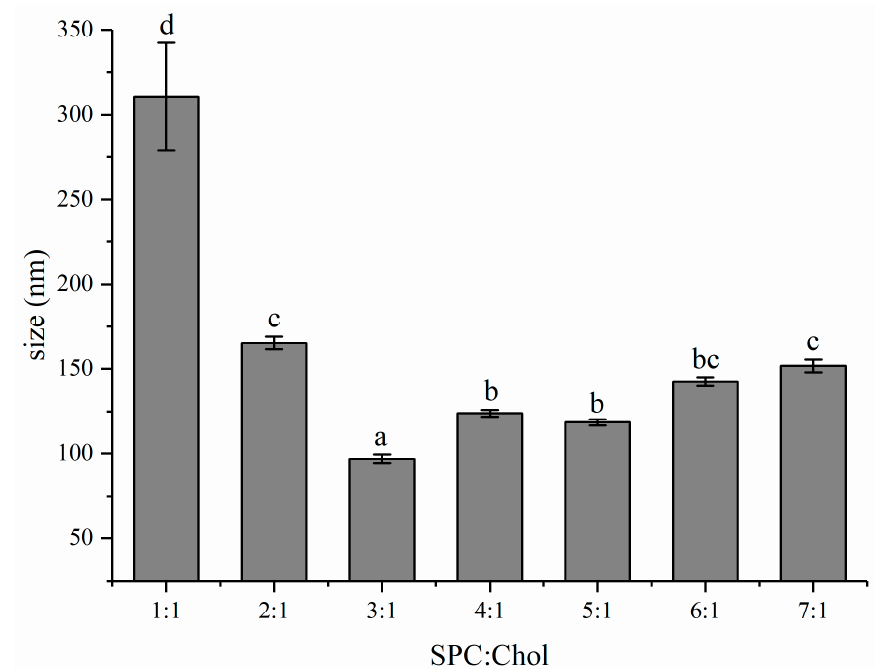
Figure 2. The e ff ects of soy phosphatidylcholine-cholesterol ratio on the size of liposomes. Di ff erent letters in this figure represent significant di ff erence among di ff erent treatment ( p < 0.05). Error bars Figure 2. The effects of soy phosphatidylcholine-cholesterol ratio on the size of liposomes. Different represent standard deviations (SD) ( n = letters in this figure represent significant difference among different treatment ( p < 0.05). Error bars represent standard deviations (SD) ( n = 3).